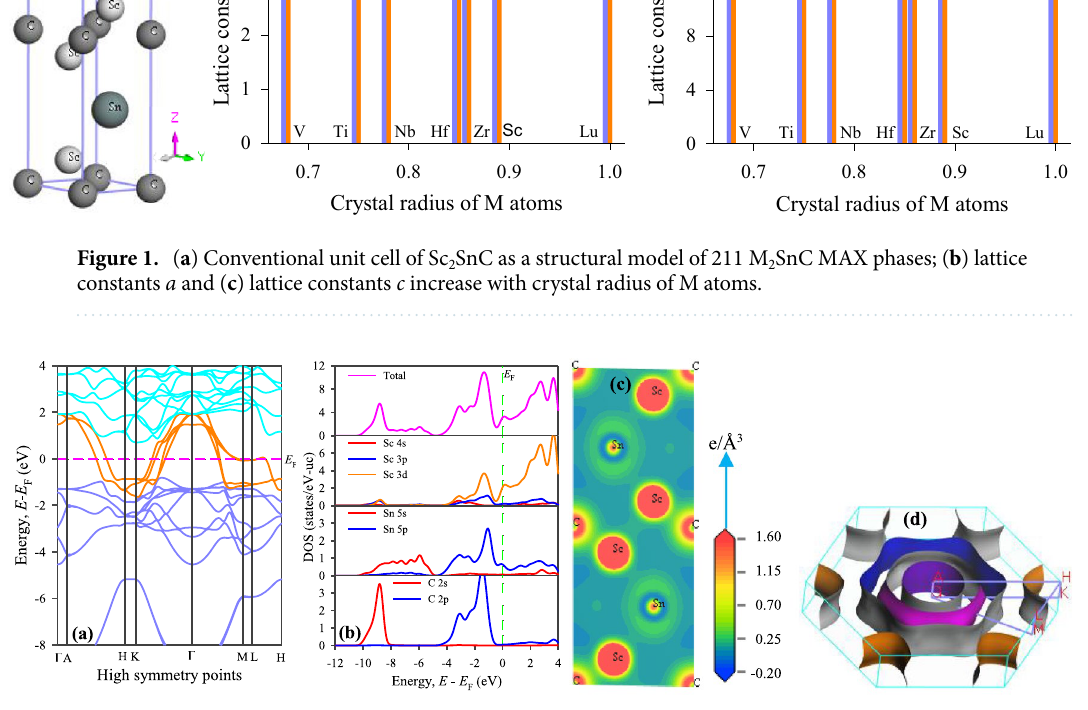
Figure 2. ( a ) Band structure, ( b ) Density of states, ( c ) Charge density map and ( d ) Fermi surface of Sc 2